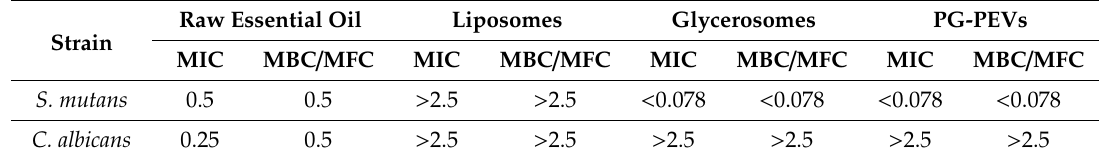
Table 6. Minimum inhibitory concentrations (MICs), minimum bactericidal concentrations (MBCs), and minimum fungicidal concentrations (MFCs) (expressed as mg / mL) of TC essential oil and TC loaded in nanovesicles against S. mutans and C. albicans determined by the broth microdilution method. Raw Essential Oil Liposomes Strain